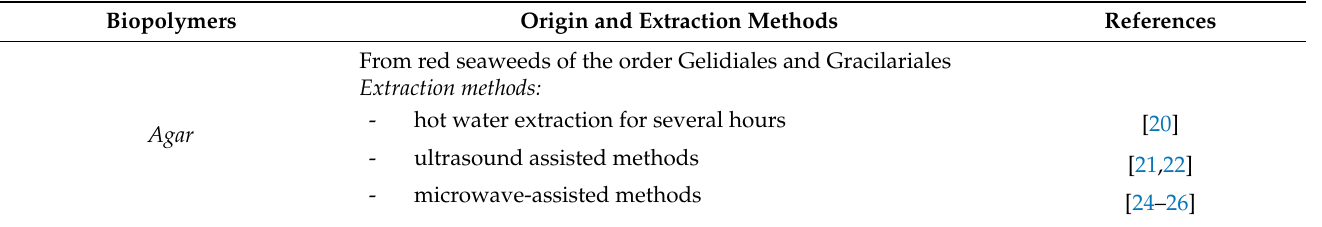
Table 1. Biopolymers’ origin, extraction methods, and